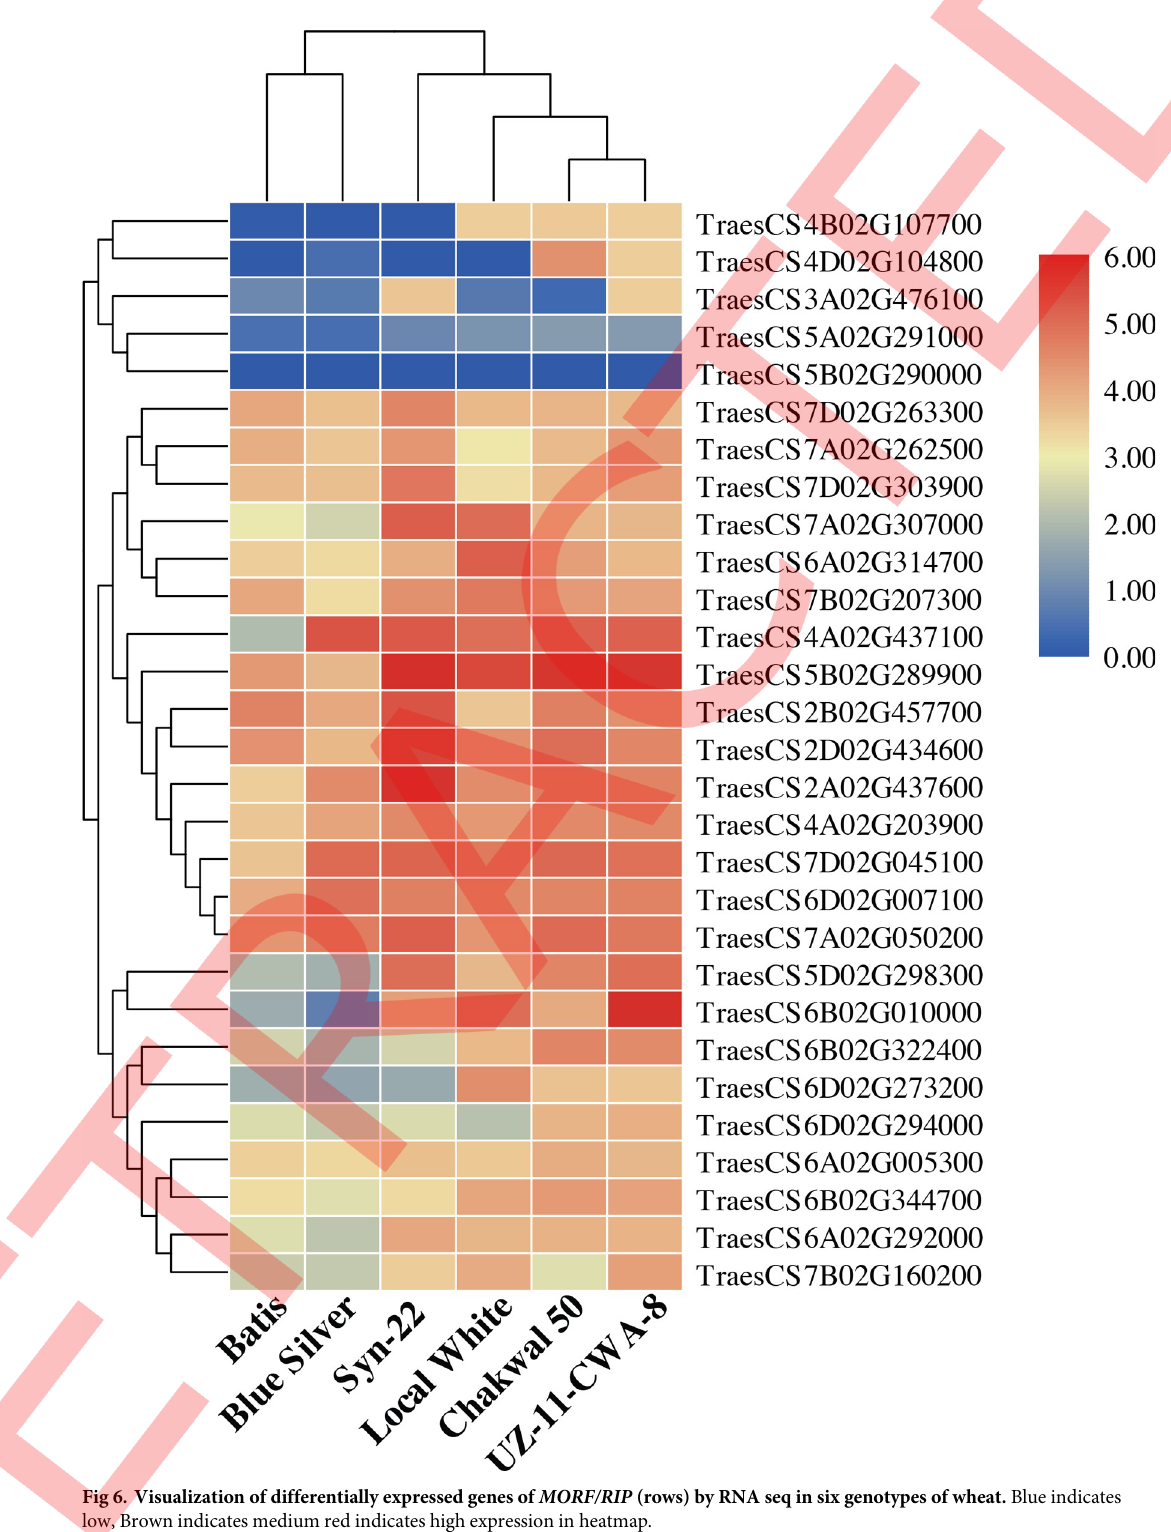
PLOS ONE | https://doi.org/10.1371/journal.pone.0265270 March 11,